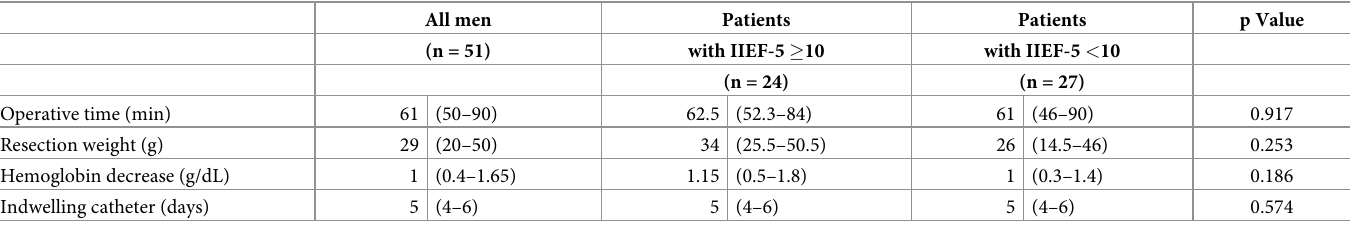
Table 2. Perioperative data.